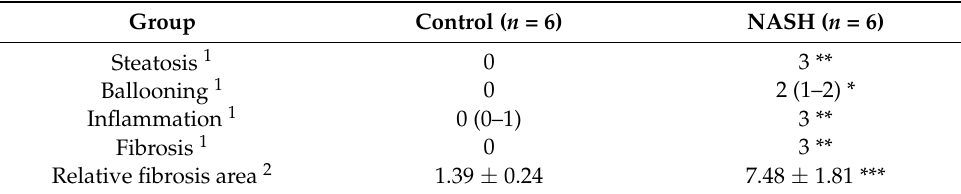
Figure 1. Representative pictures of the distribution of hepatic fibrotic tissue in control and NASH (stage F3) guinea pigs in Picro Sirius red stained sections. ( A ) In control animals, fibrous tissue (red) surrounds the central veins and portal areas, but does not expand into the hepatic parenchyma. An isolated small area of fibroplasia (arrowhead) can be seen as a normal occasional finding. ( B ) Bridging fibrosis (arrows) (F3 grade) is clearly evident in animals with NASH after 25 weeks on a high-fat diet. Table 2. Histological scoring of control and NASH guinea